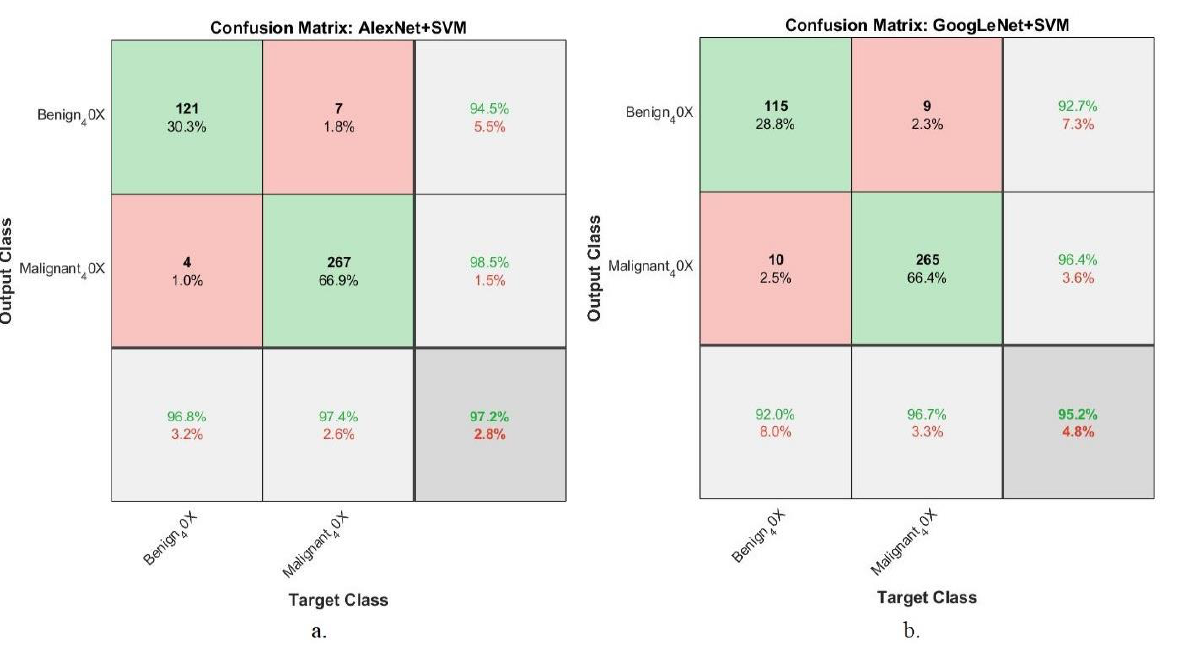
Figure 6. Evaluation of a BC dataset with a magnification of 40× by the confusion matrix produced by ( a ) AlexNet + SVM and ( b ) GoogLeNet + SVM.